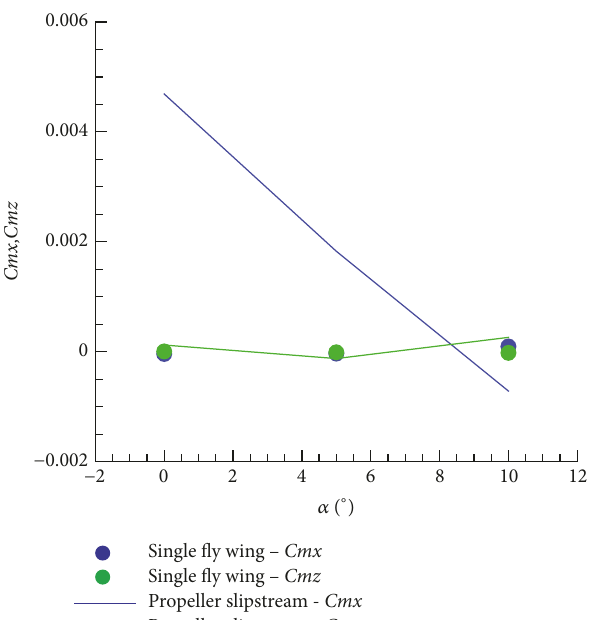
Figure 20: Steady aerodynamics, rolling moment coefficients Cmx and yawing moment coefficients Cmz .